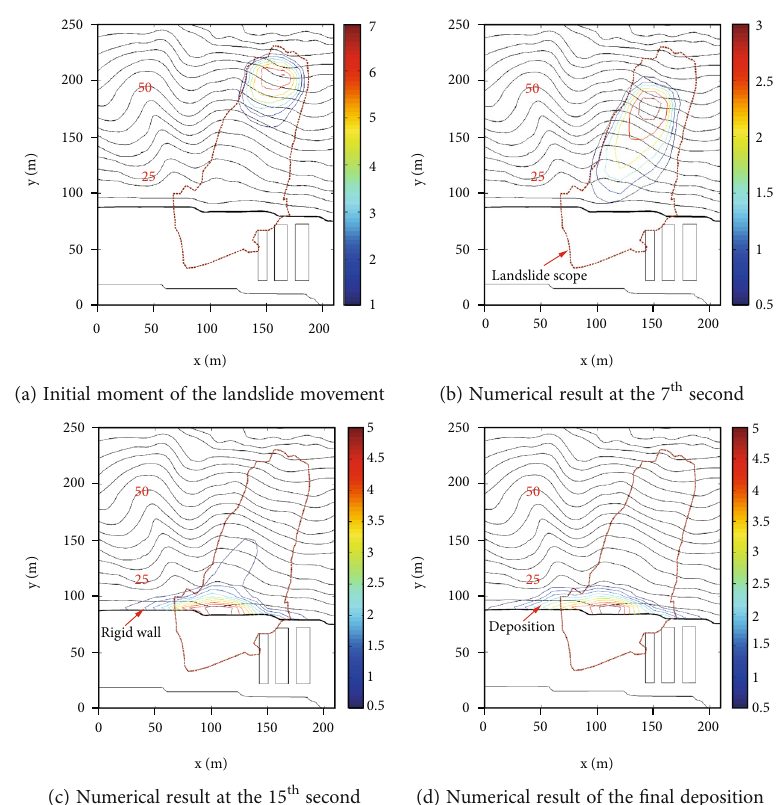
Figure 6: Flow depth contour map of landslide process blocked by rigid retaining wall.